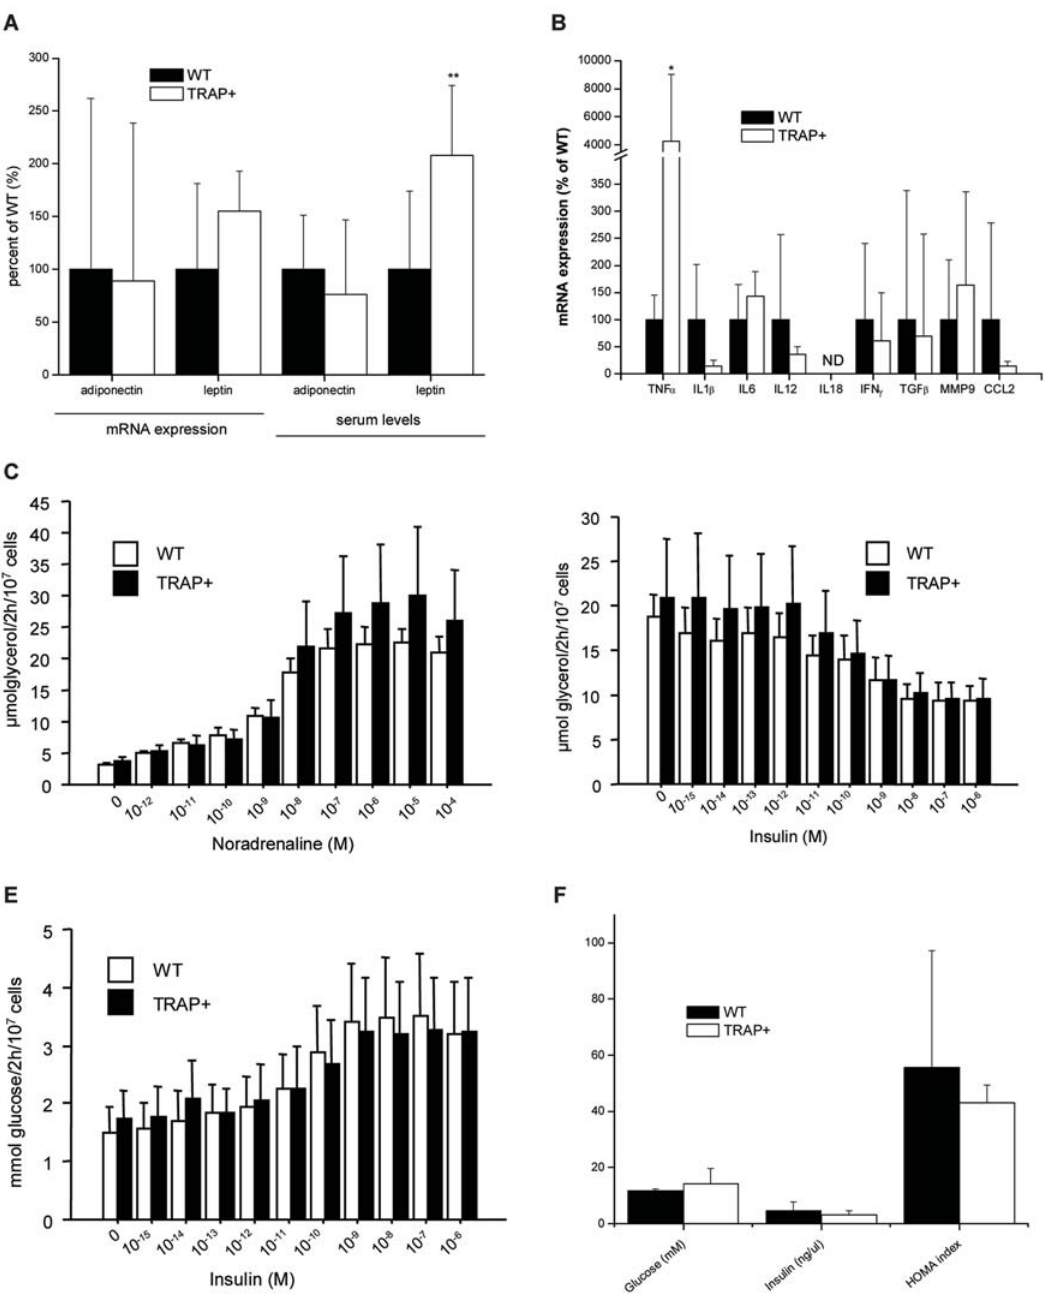
Figure 6. Metabolic and inflammatory profile of adipose tissue from obese TRAP over expressing mice. (A) Levels of leptin and adiponectin mRNA and serum protein in WT and TRAP + mice. (B) Inflammatory gene expression profile in the TRAP + mice. (C) Noradrenalin- stimulated lipolysis in isolated adipocytes from TRAP + and WT mice. (D) Insulin-inhibitable lipolysis in isolated adipocytes from TRAP + and WT mice. (E) Insulin- stimulated lipogenesis in isolated adipocytes from TRAP + and WT mice. (F) Levels of blood glucose and insulin in TRAP +